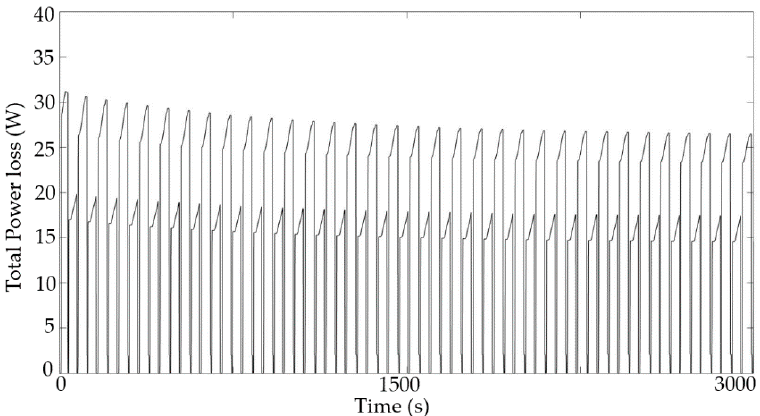
Figure 3. Current and voltage profiles of the experimental tests: ( left ) the whole test during 3000 s, and ( right ) the first slice of charging and discharging.